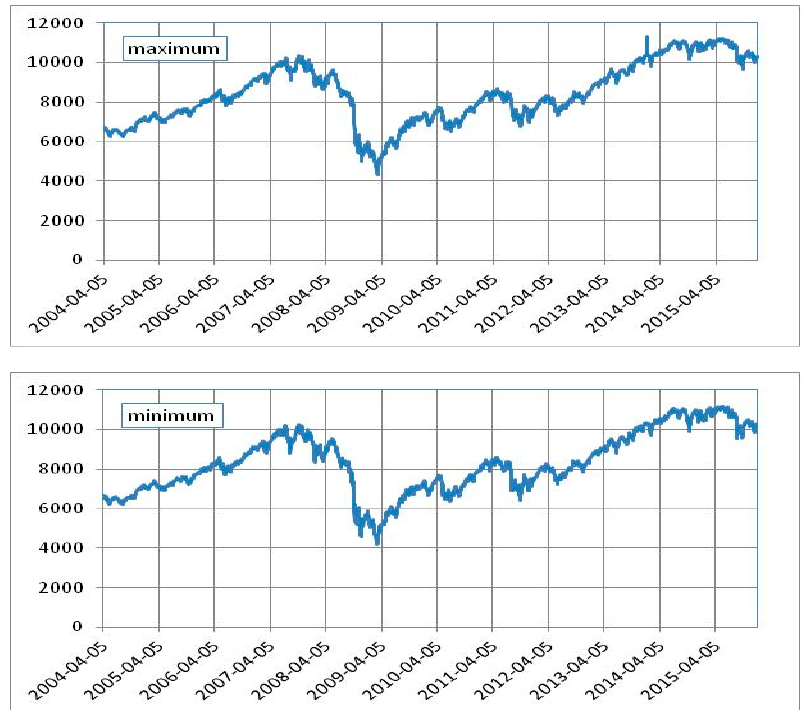
Figure 3. Evolution over time of the values of daily maximum (above) and minimum (below) of the NYSE Composite US 100 between 5 April 2004 and 31 December 2015.